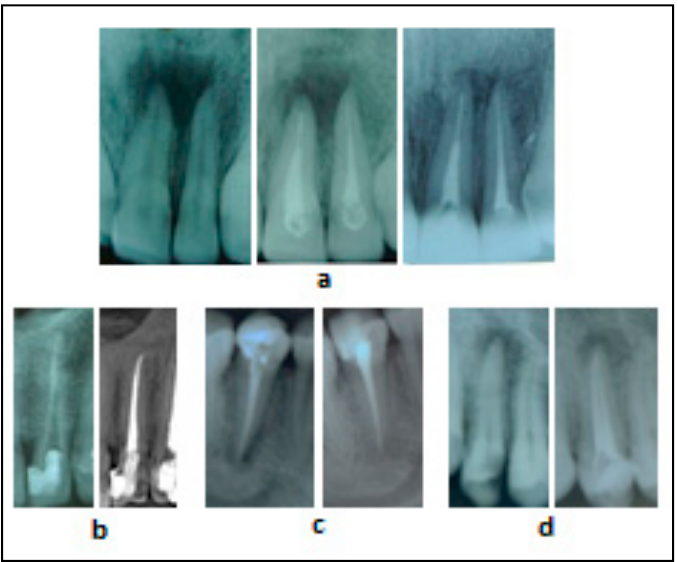
Figure 1. Radiographs of apical periodontitis cases from the control group. ( a ) female, 55-years old, teeth no. 21 and 22 (before treatment, after 6 and 18 months); ( b ) male, 40-years old, tooth no. 22 (before treatment and after 18 months); ( c ) female, 45-years old, tooth no. 45 (before treatment and after 18 months); ( d ) male, 19-years old, tooth no. 24 (before treatment and after 12 months).